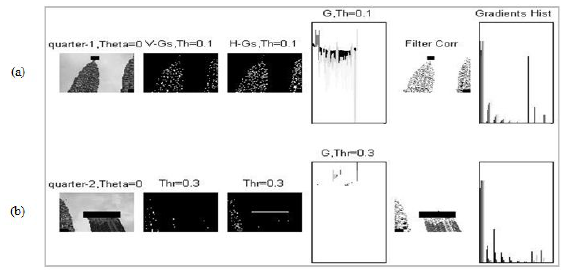
Fig. 9. Test image gradients: (a) vertical and horizontal Fig. 10. Test image gradients: (a) Vector angle = 0, gradients of the full test image, threshold = 0.1 with a threshold to the vertical and horizontal gradients = 0.1, histogram of those gradients, (b) gradients of the 1 st filter correlation with a histogram of those gradients, (b) quarter image, threshold = 0.2; (c) gradients of the 2 nd theta = 0, threshold to the vertical and horizontal gradients quarter image, TH=0.3, (d) 3 rd quarter image, TH=0.4 and = 0.3, TH=0.3 with a histogram of those (e) 4 th quarter image, TH=0.5.